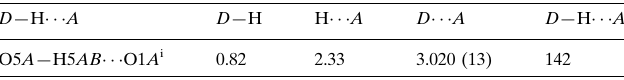
Hydrogen-bond geometry (A˚ , (cid:2)